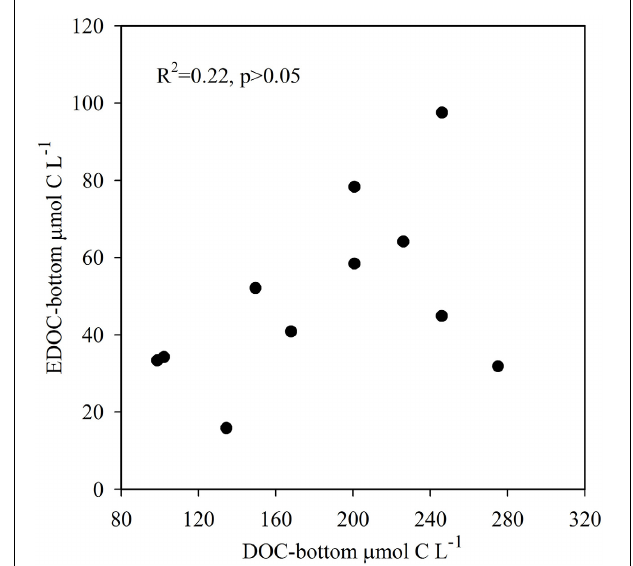
FIGURE 2 | Relationships between temperature and DOC: closed squares represent DOC in bottom waters where the collection of cores took place ( R 2 = 0 . 84), open circles represent DOC collected just below the surface of the water ( R 2 = 0 . 82). Both relationships are significant ( p < 0 . 05).